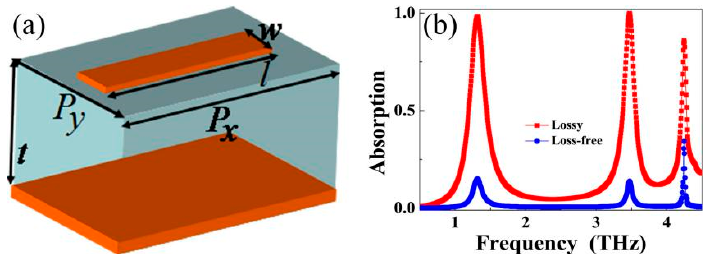
Figure 1. ( a ) Three-dimension unit cell of triple-band light absorber; ( b ) absorption spectra of the triple-band light absorber having the dielectric constant of lossy (or imaginary part is not zero, see red curve) and loss-free (or imaginary part is zero, see blue